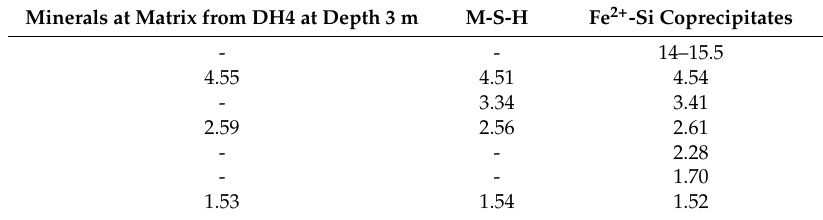
Table 3. Details of d-spacings of the solid phase with Si, Fe, and Mg, in the matrix of DH4 at 3 m determined by TEM, the M-S-H data by XRD [9], and the Fe 2+ -Si coprecipitates data by XRD [20]. All d-spacings are in